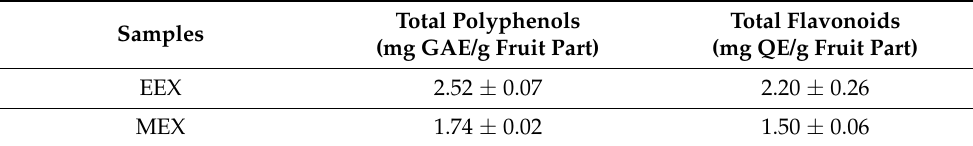
Table 4. Total polyphenols and flavonoids of EEX and MEX.